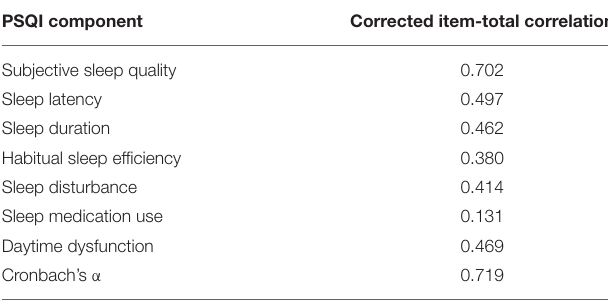
TABLE 1 | Sample characteristics. TABLE 2 | PSQI internal consistency data.